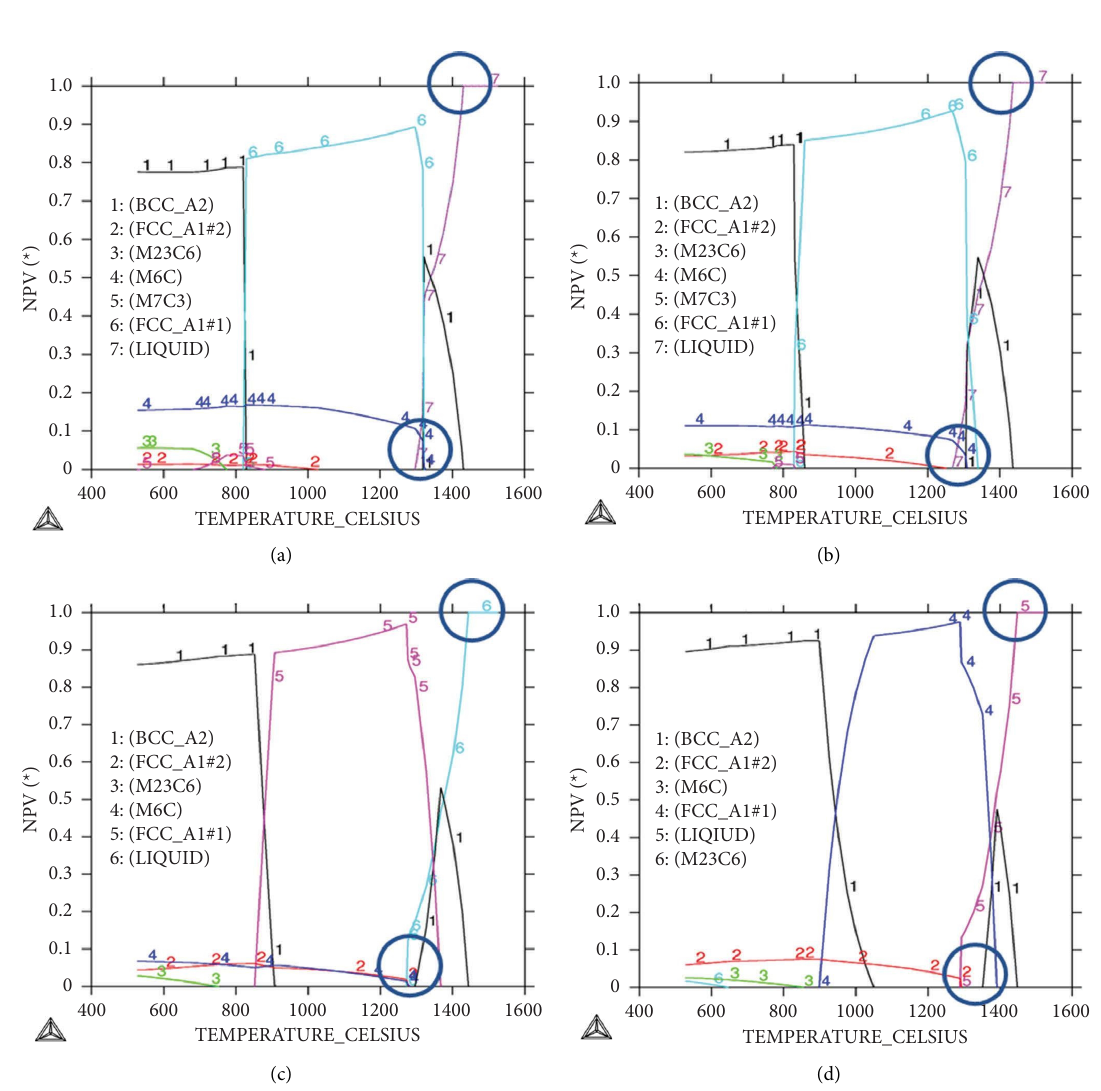
Figure 1: Solidifcation path of T1 high-speed tool steel and vanadium-modifed variants. (a) 1V-18W; (b) 2V-13W; (c) 3V-8W; (d) 4V-3W.